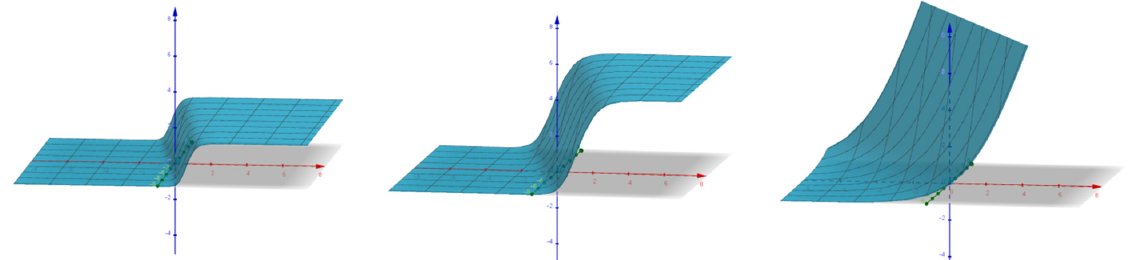
Figure 1. When n = 1, fix α = − 1.8 and take β as − 4.4, − 2 and − 0.5 respectively. For the travelling wave solutions of Equation (17), when n = 1, β = − 1.5, the corresponding graphs of α = − 4.2, − 1.5 and − 0.5 are given as follows (Figure 2):